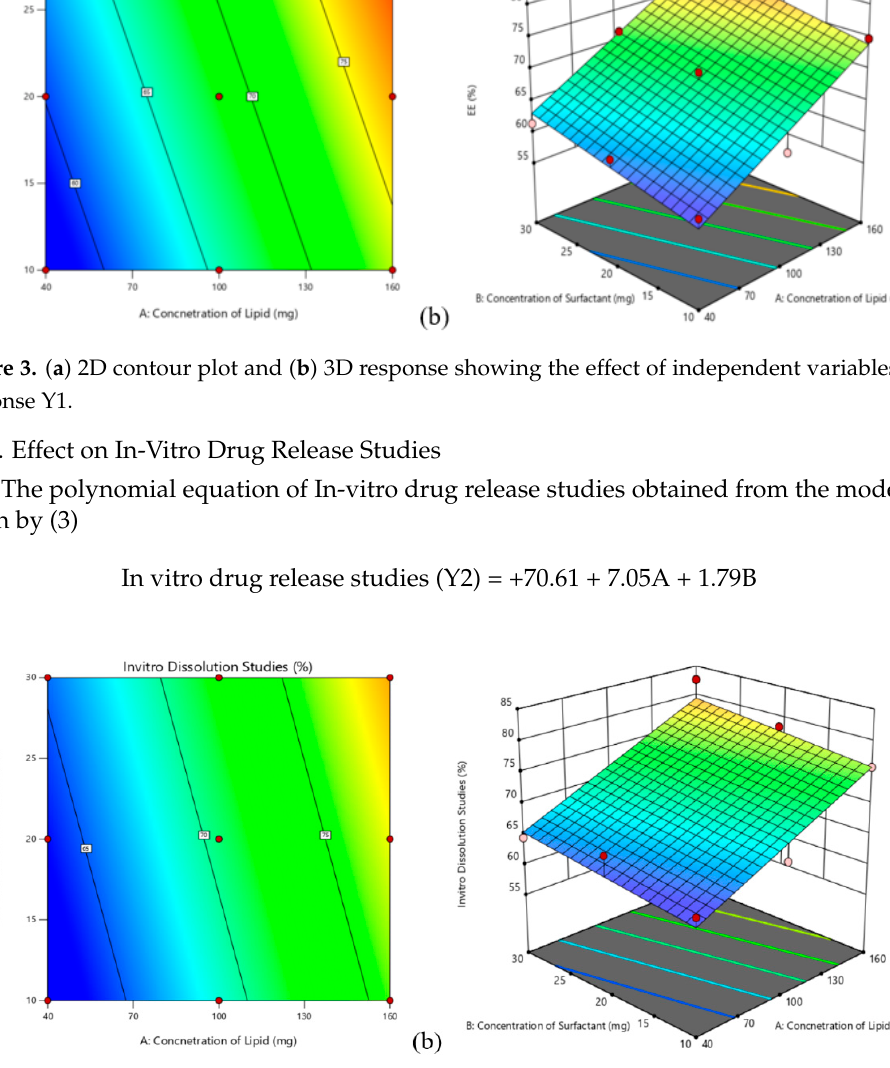
Figure 4. ( a ) 2D contour plot ( b ) 3D response showing the effect of independent variables on re- sponse Y2.